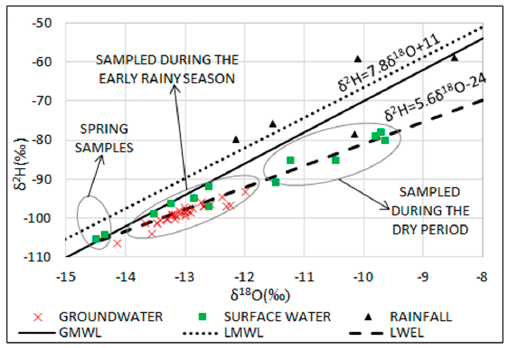
Figure 3. Isotopic ( 2 H and 18 O) variations in groundwater, rainfall, and surface water samples. The global meteoric water line (GMWL), the local meteoric water lines (LMWL), and the local evaporation water line (LEWL) are also displayed.